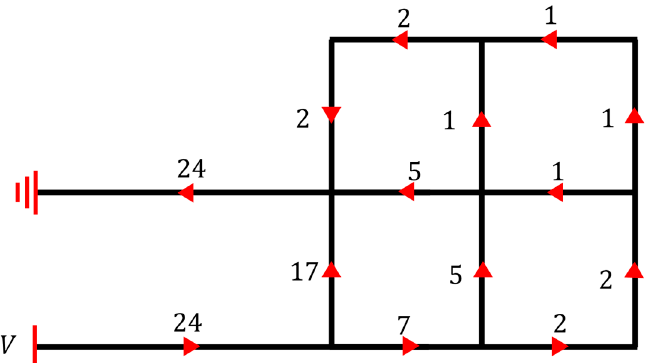
Figure 4. The current distribution across the beam structure (red arrows denote the current directions, while the numbers near the arrows represent the current division factors among different beams).